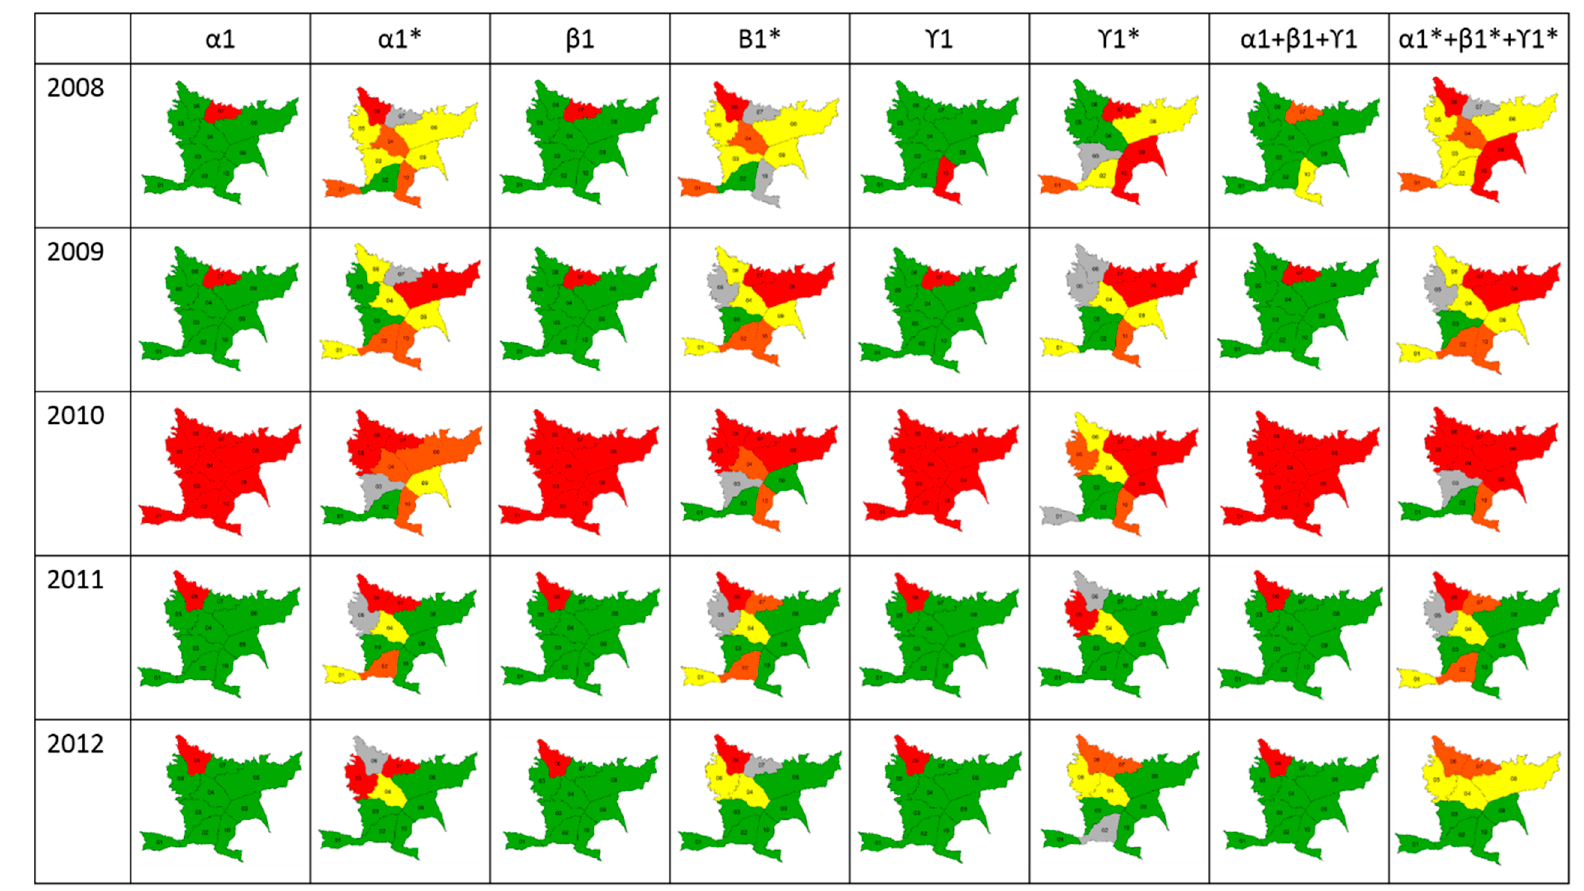
Figure 4. Scale of risk. Maps show the classification of each index and the merged indices using the Standard Deviation (SD) and LISA methodologies (*).